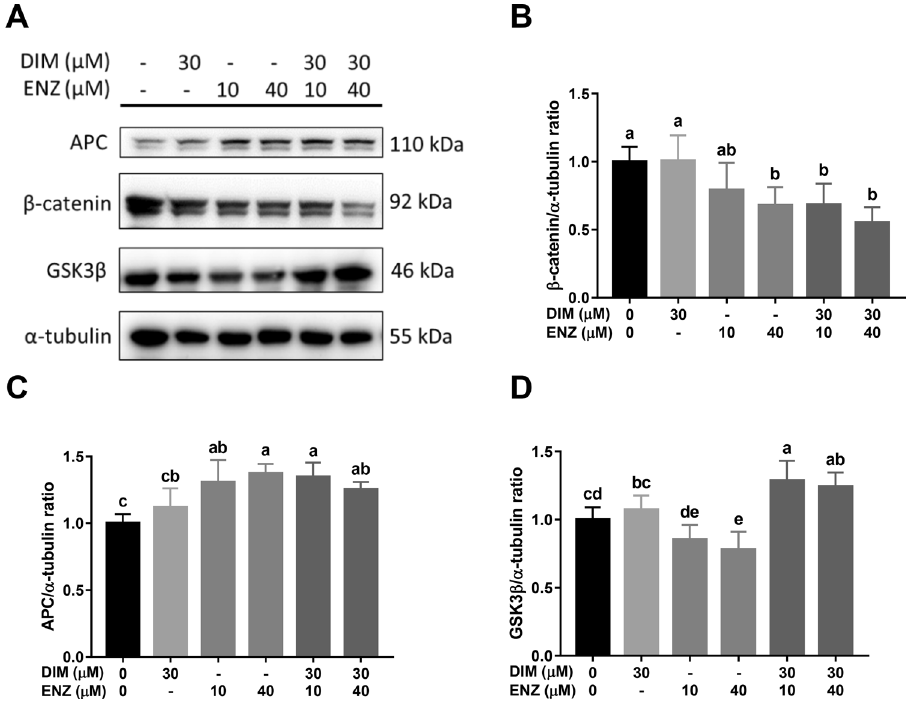
Figure 5. Inhibition of Wnt signaling by DIM and ENZ co-treatment in 22Rv1 cells at 48 h. Representative western blot image ( A ); quantitative results for β-catenin ( B ), APC ( C ), and GSK3β ( D ). DIM 3,3 ′ -diindolylmethane; ENZ enzalutamide. Values are presented as means ± SD. a,b,c,d Bars without the same letters at the top indicate statistically-significant differences between treatments when compared with each other (one- way ANOVA, Duncan’s new multiple range test, p <